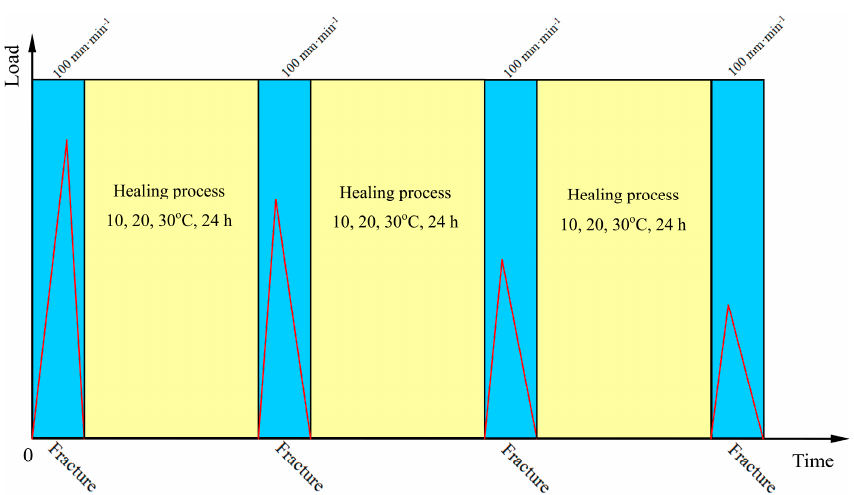
Figure 3. Illustration of the relationship between the time and fracture with a repetitive tension test.